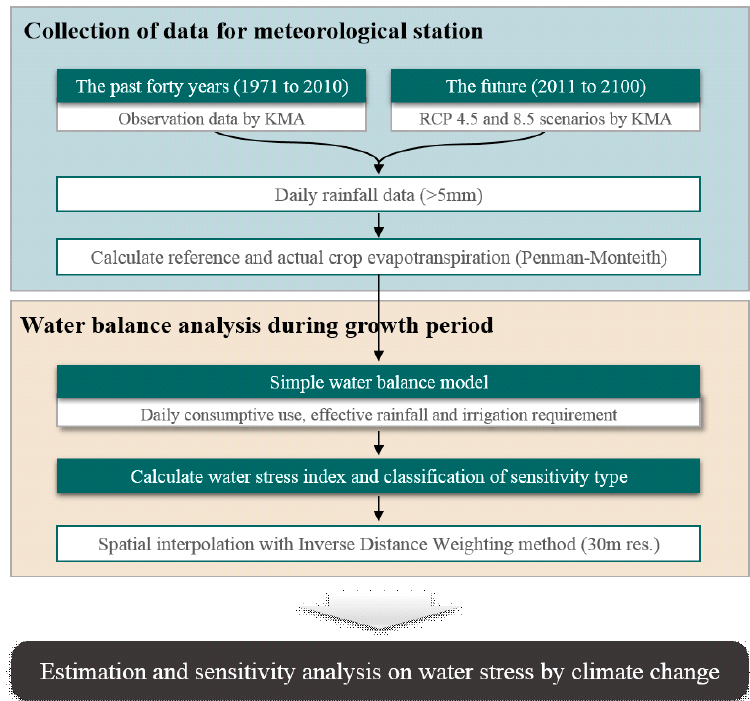
Figure 1. Procedures for evaluating sensitivity of paddy rice to climate change.